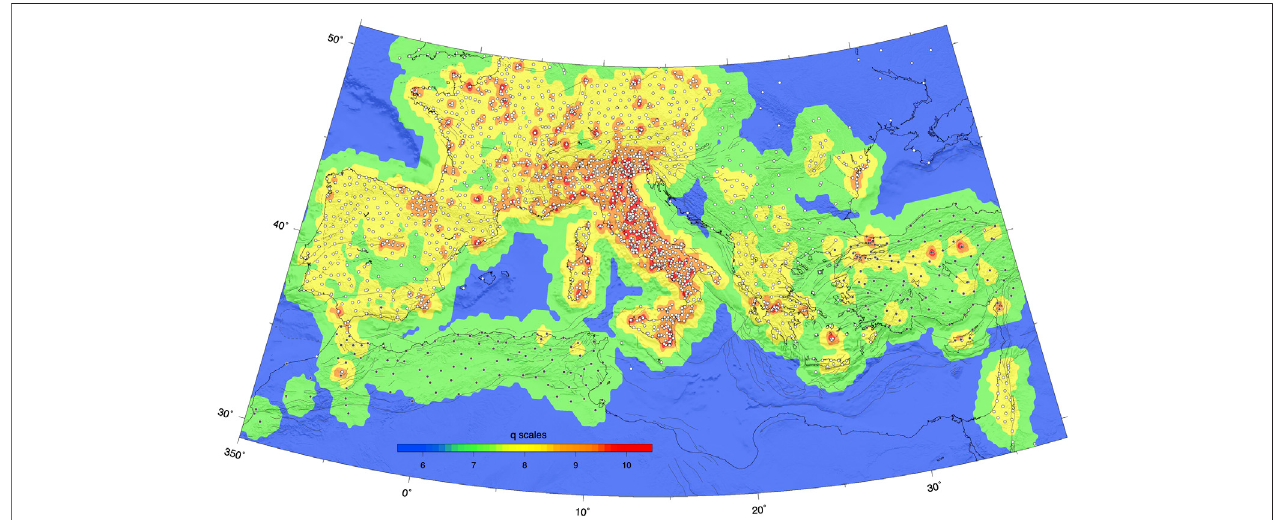
FIGURE 7 | Maximum values of spherical-wavelet orders based on the GNSS station distribution (white circles from the analysis discussed in this work, black circles from literature). The interval q = 1 – 10 is considered but only the 6 – 10 (~110 – 7 km) interval is shown in fi gure. The density of the geodetic points controls the selection of spherical wavelets, whose center points are not shown in this map. The color map shows the maximum-q scale wavelet that covers each area where the coverage is determined by the length scale for each spherical wavelet. Where stations are dense, wavelets with all scales q = 1 – 10 (red corresponds to length scales of ~7 km) are available; where stations are sparse, only wavelets with longer length scales q = 4 – 7 (green corresponds to length scales of ~55 km) are